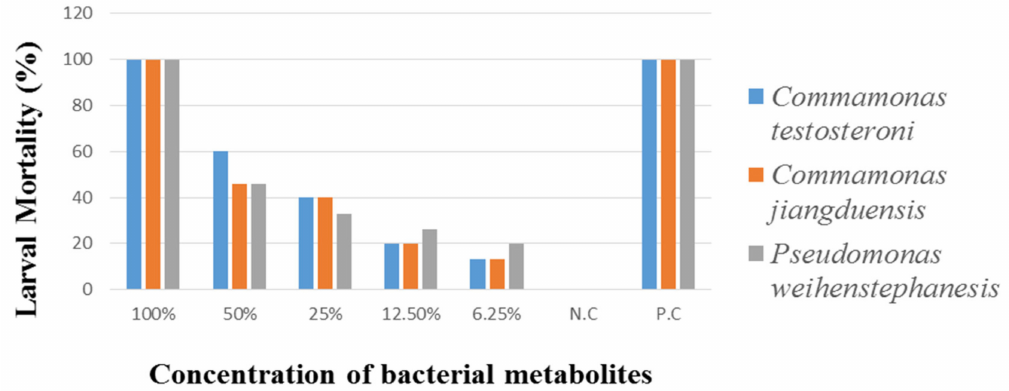
Figure 5. Percent nematode larval mortality by the bacterial isolates after six hours of treatment. Comamonas jiangduensis showed 100% larval mortality at 100% bacterial metabolite concentration; at a 50% concentration the mortality was recorded as 46%, while the lowest dose (6.25%) of metabolite concentration caused the lowest (13%) mortality of L3 larvae. Analysis of the data showed that P. weihenstephanesis with 100% metabolite concentration caused 100% mortality of H. contortus’ L3 larvae, which was followed by a 46% mortality rate, where 50% bacterial metabolite concentration was used. The lowest concentration of P. weihenstephanesis showed the lowest L3 mortality (20%), as in the case with the